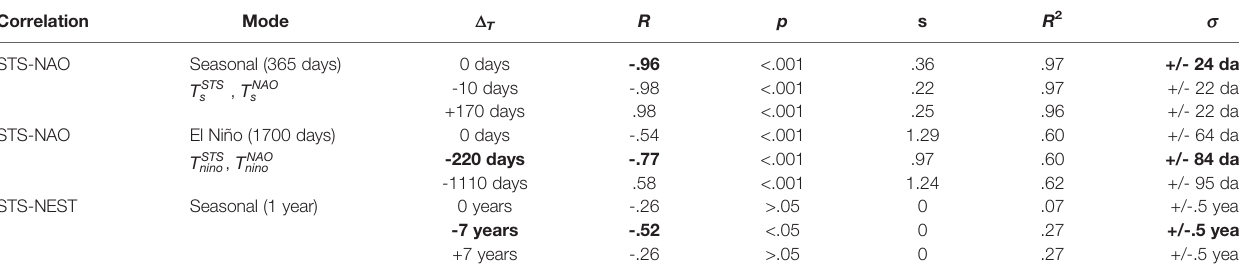
TABLE 1 | Correlation between sea turtle sightings (STS) in Madeira, Hurrell North Atlantic Oscilation Index (NAO) and nests on core index beaches in peninsular Florida (NEST). Correlation Mode D